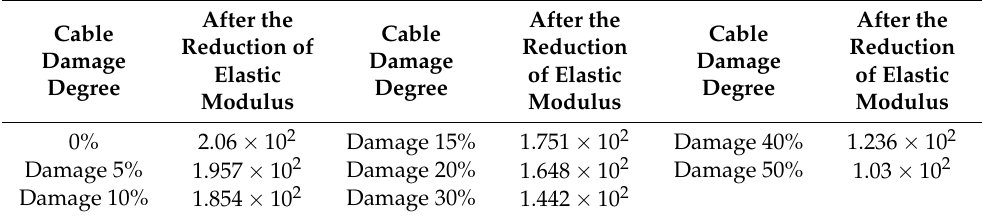
Table 2. Value of elastic modulus of the cable after reduction GPa.